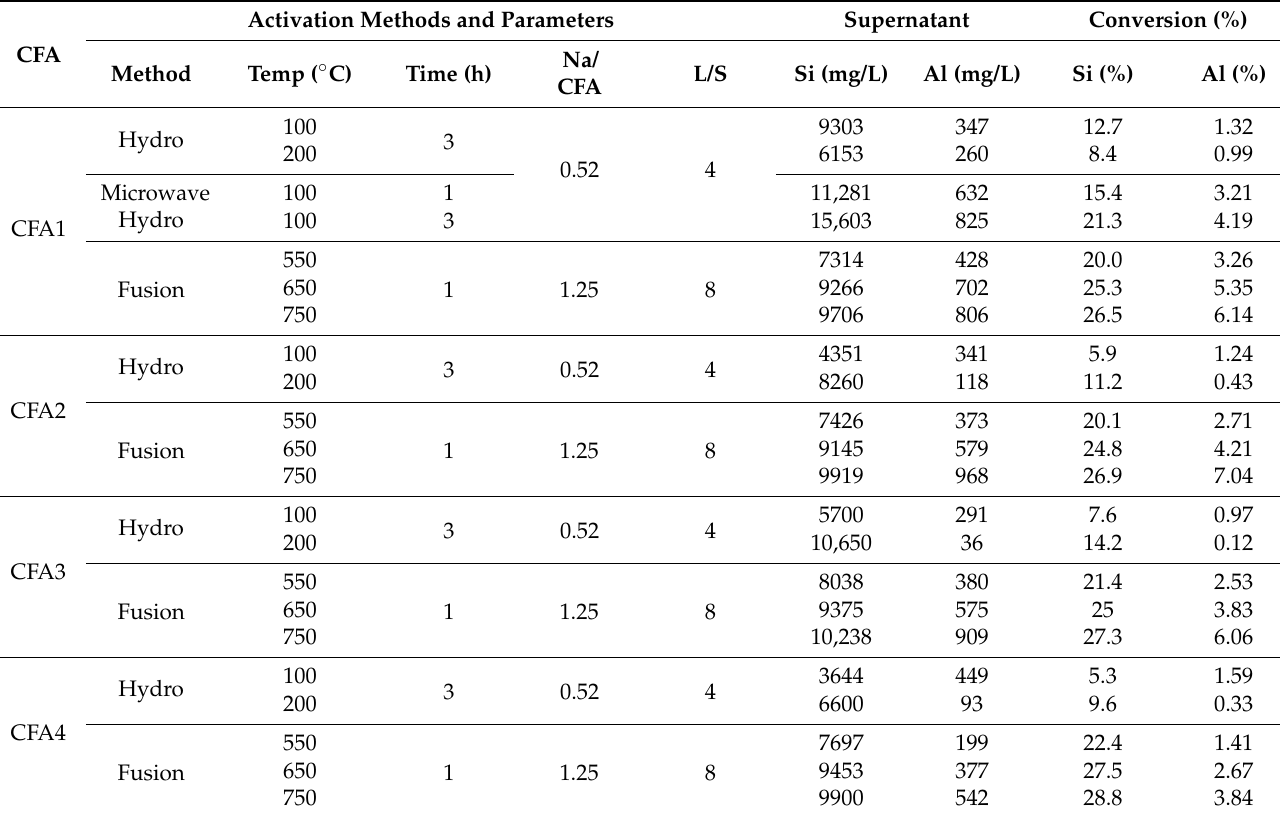
Table 2. CFA activation methodologies, treatment parameters, and